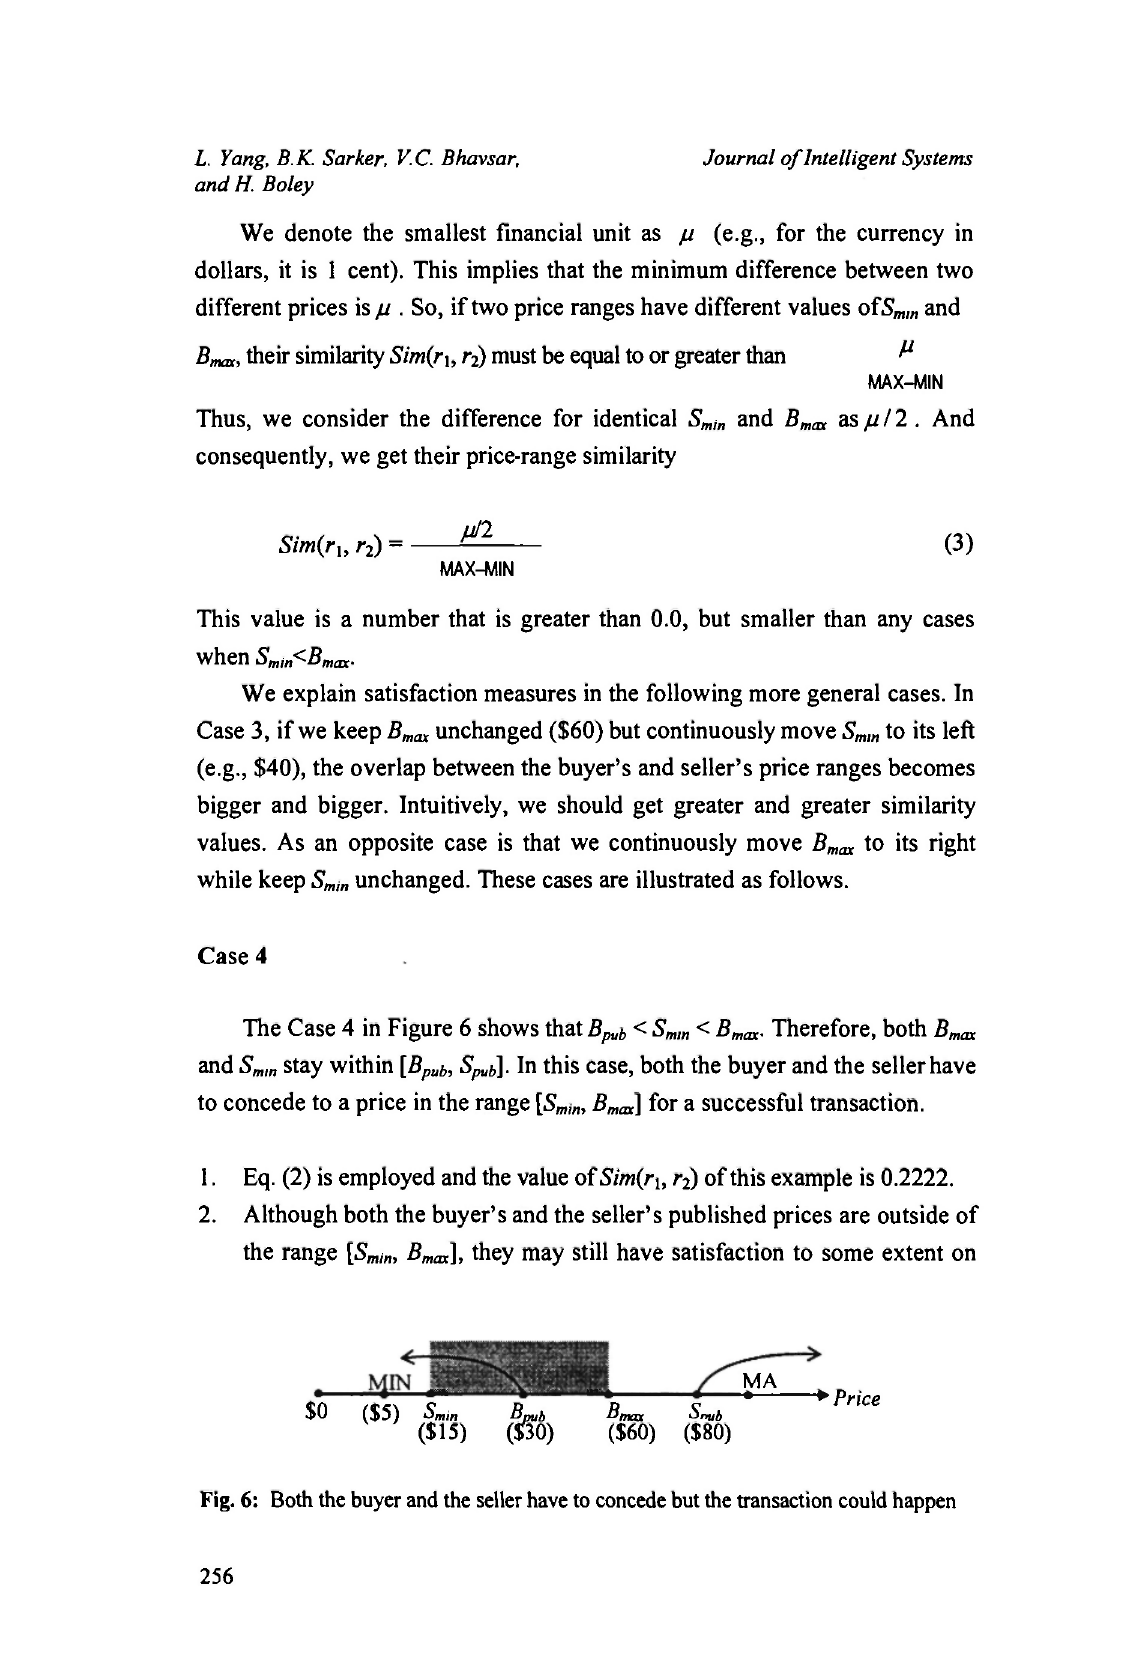
Fig. 6: Both the buyer and the seller have to concede but the transaction could happen